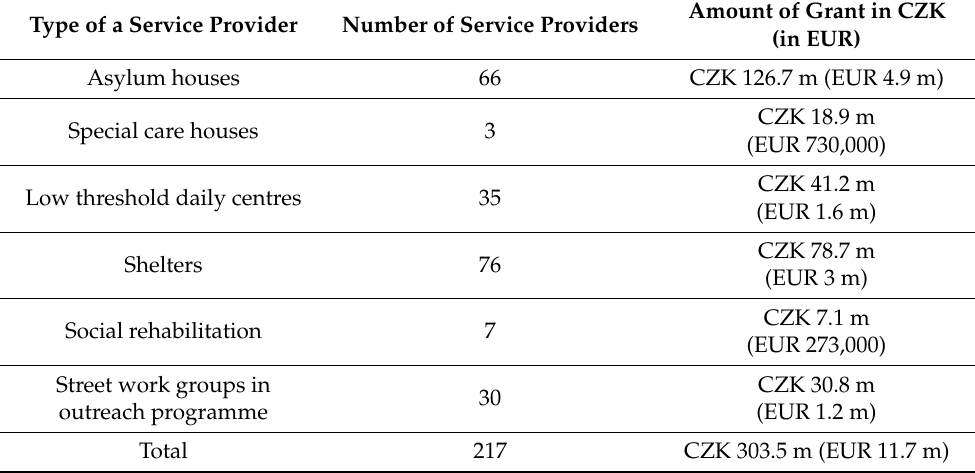
Amount of Grant in CZK (in EUR)